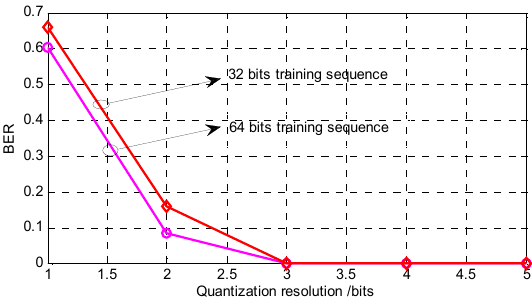
Figure 6. Error rate curve with low resolution.